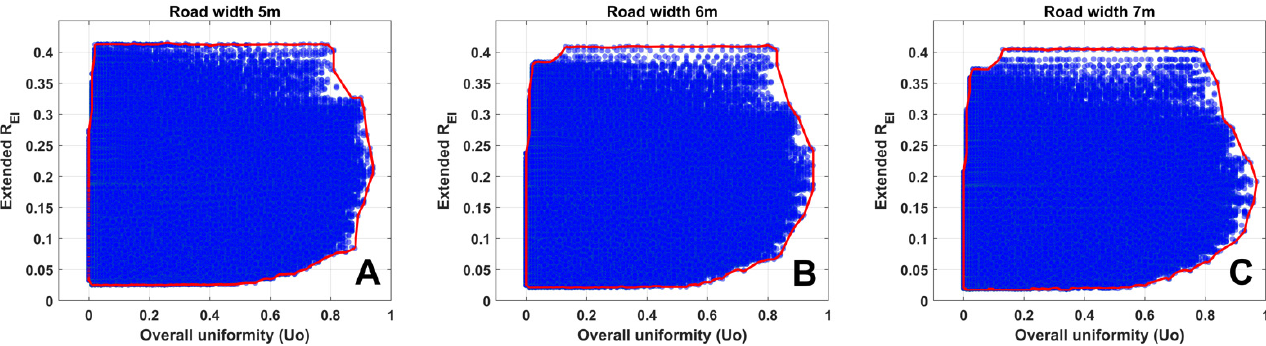
Figure 12. Uniformity vs. Extended R EI (up to 20 m left and right). Simulation results for all cases. The graphs include all potential pole arrangements, as shown in Table 1: ( A ) results for road width of 5 m; ( B ) results for road width of 6 m; ( C ) results for road width of 7 m.